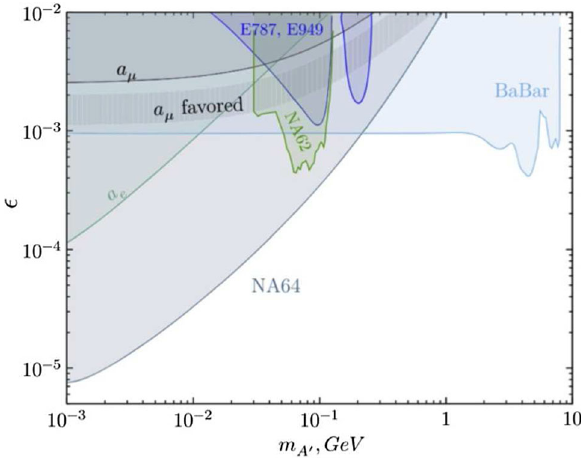
Fig. 1 The existing limits for the massive dark photon going to invisi- ble final states. The constraints from a e = ( g − 2 ) e and a μ = ( g − 2 ) μ are also shown. The figure is taken from